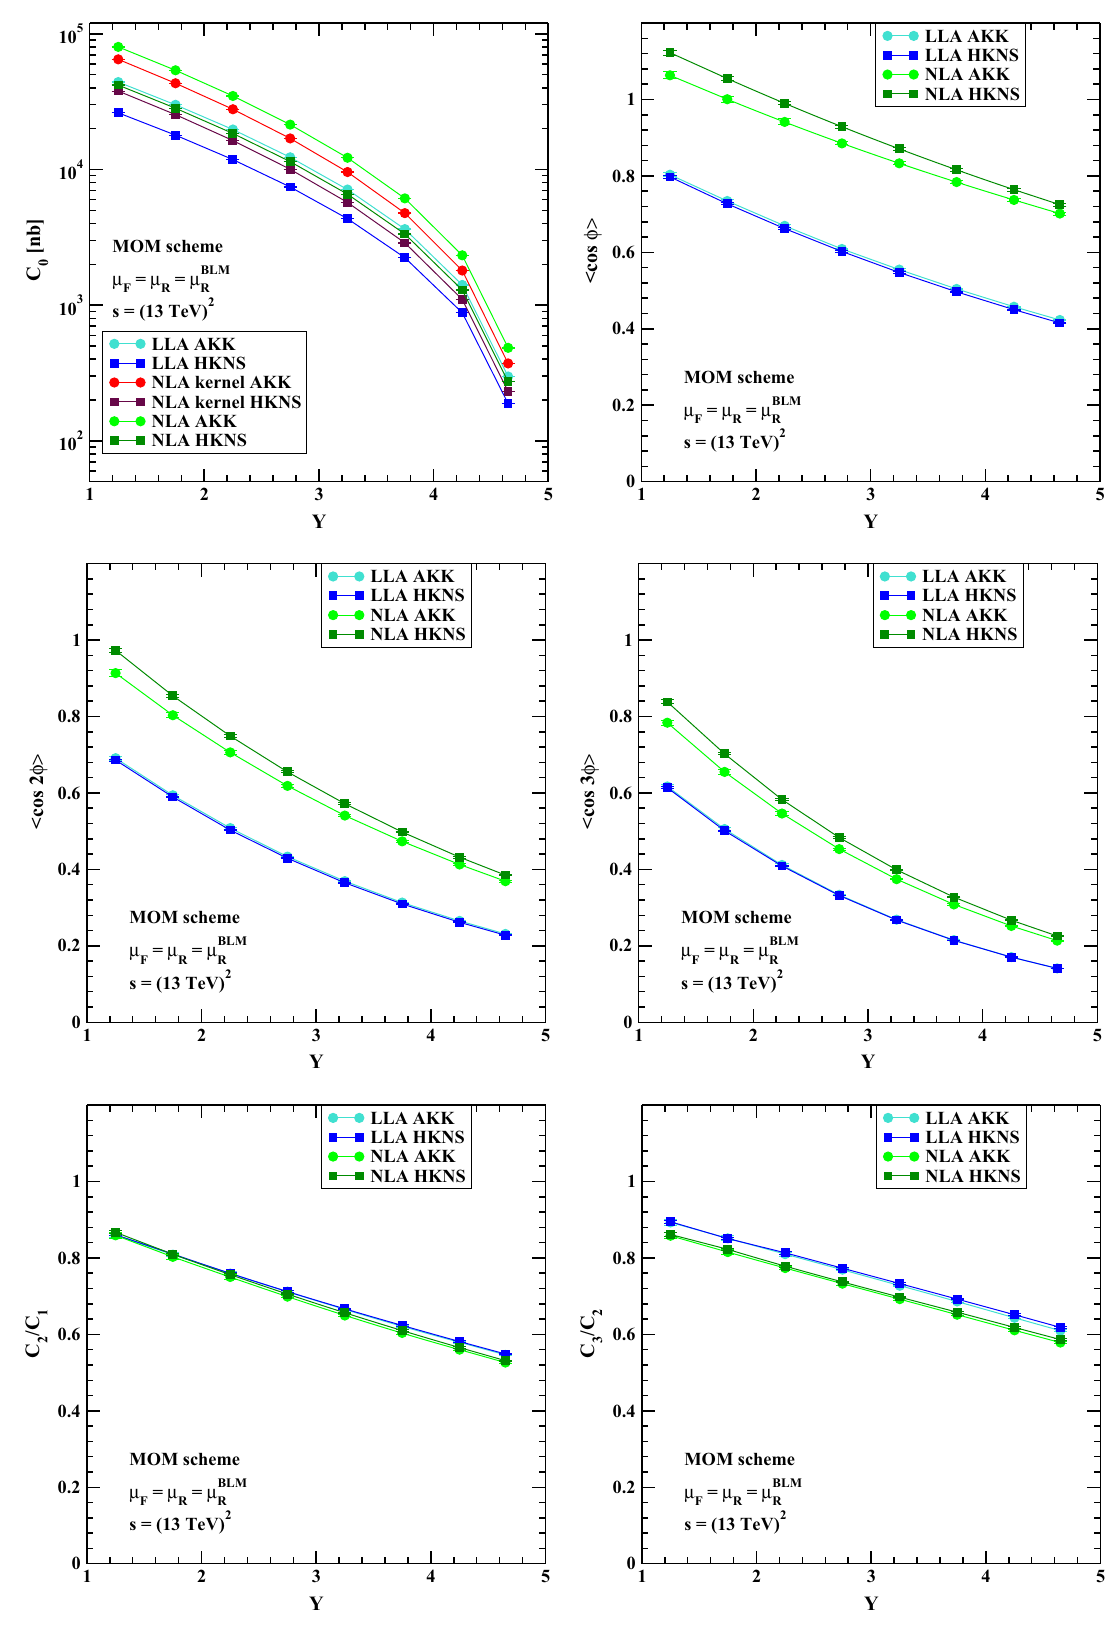
Fig. 4 Y -dependence of C 0 and of several ratios C m / C n for μ F = μ BLM